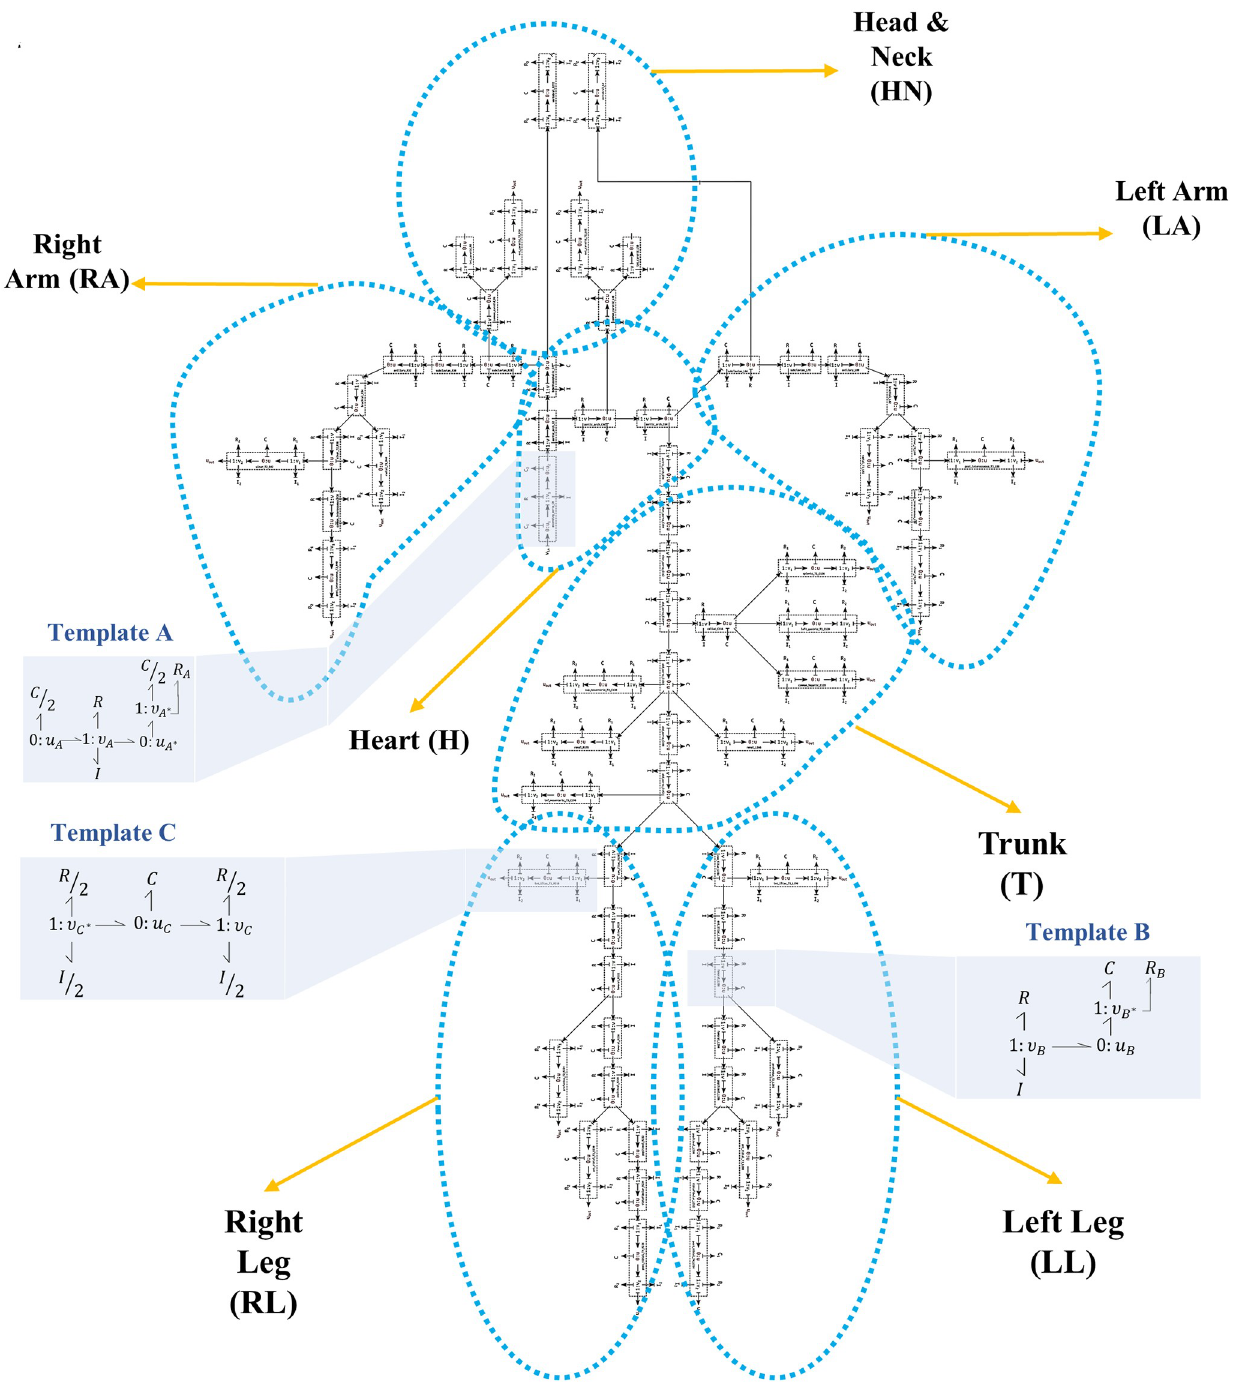
Fig 9. Vessels network in the ADAN open-loop model. The blue dashed shapes delineate the segments in each lumped module. The three bond graph templates of Fig 3 are shown in blue boxes for three exemplar segments. The segments network is adopted from [25].